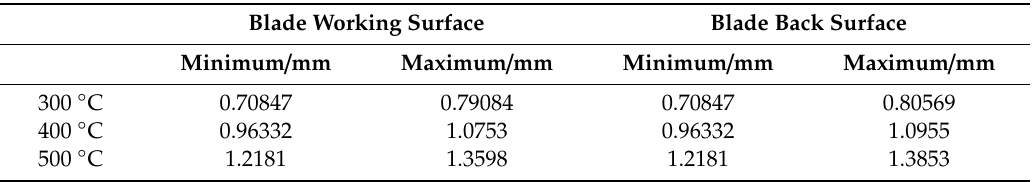
Table 4. Data related to blade working surface and back surface thermal deformation under different working conditions.